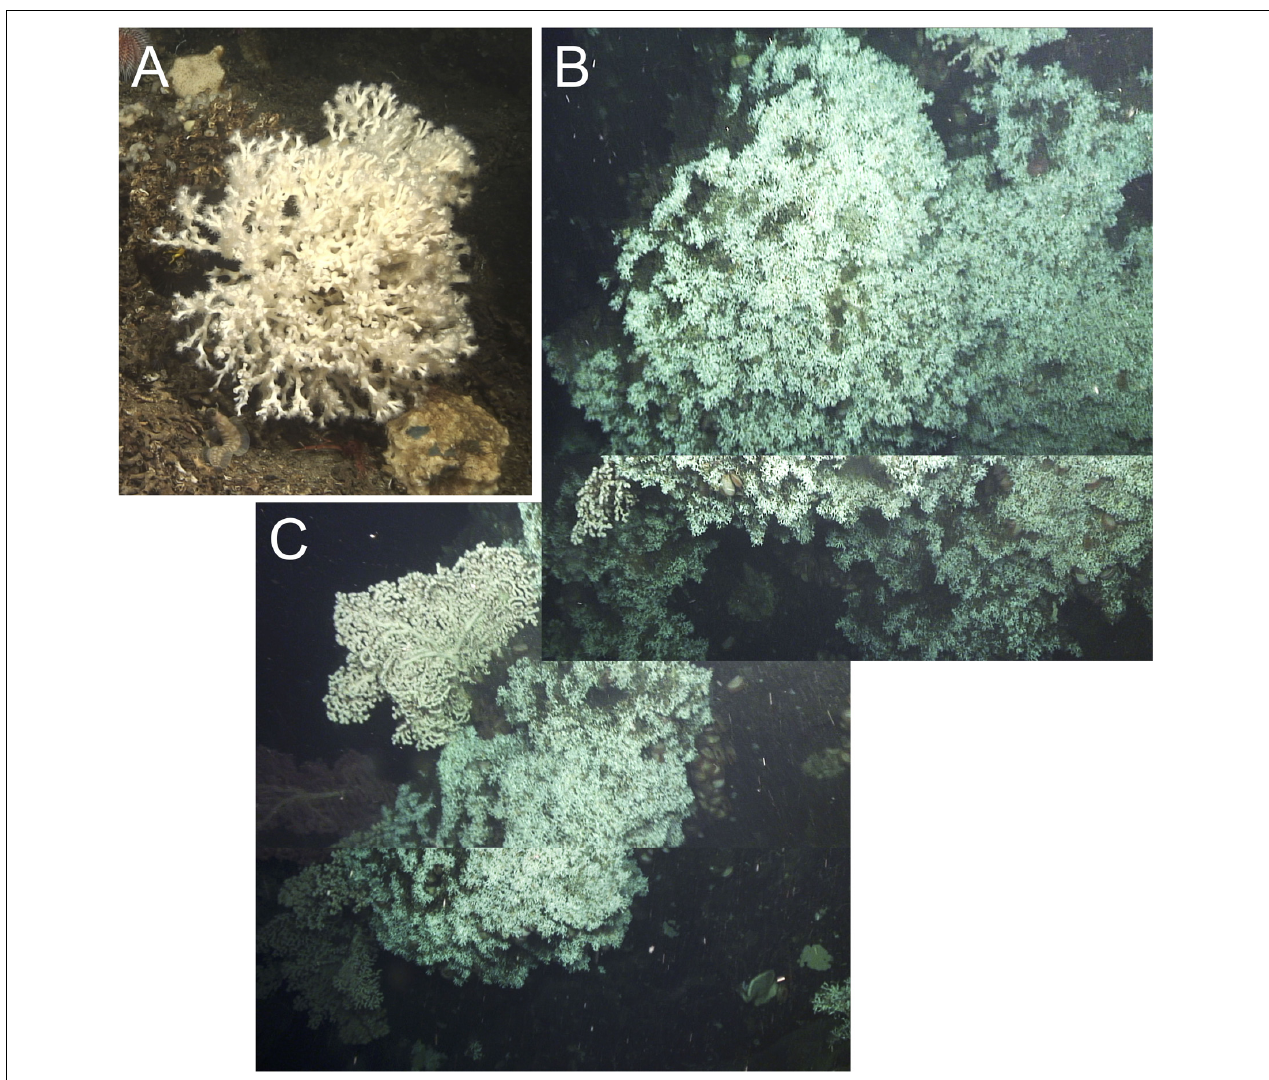
FIGURE 6 | Lophelia pertusa colonies from the vertical wall at Straumsnes (A) small single colony 25 cm in diameter, (B) L. pertusa lobe 280 cm high and 350 cm wide and (C) L. pertusa lobe 300 cm high and 180 cm